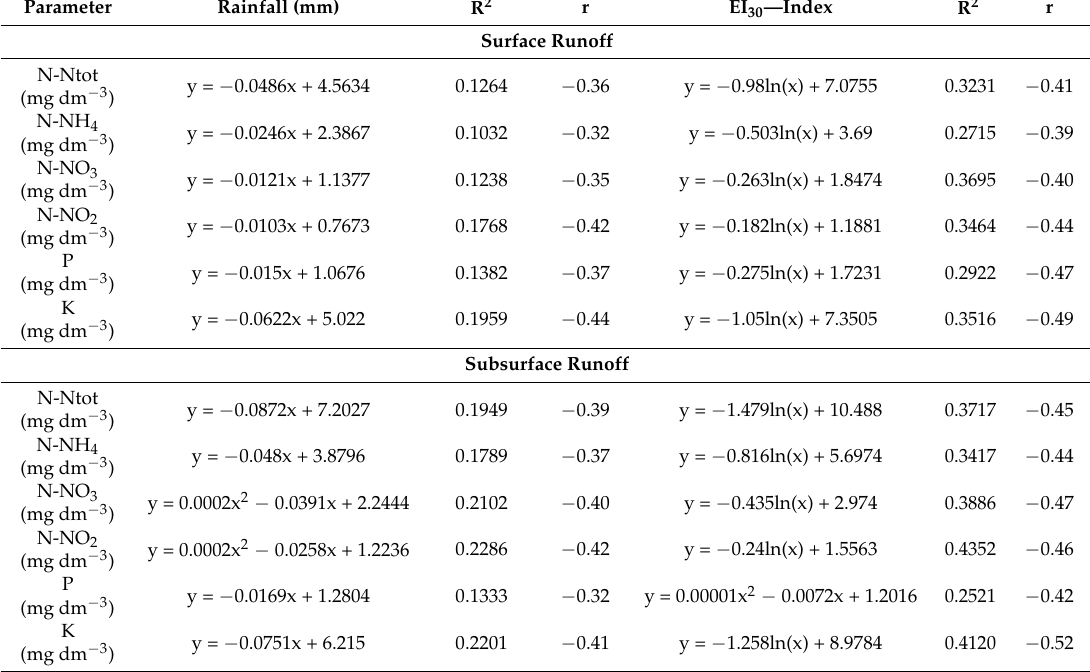
Table 7. Equation of the dependence of water quality indicators on the concentration of the surface and subsurface runoff water depending on the amount of precipitation and indicator EI 30.